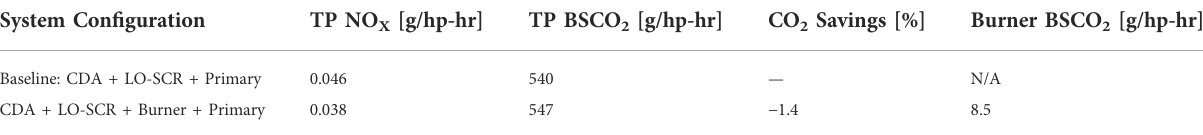
TABLE 4 Cold start HD-FTP results comparison between Baseline and CDA + LO-SCR + Burner + Primary system. System Con fi